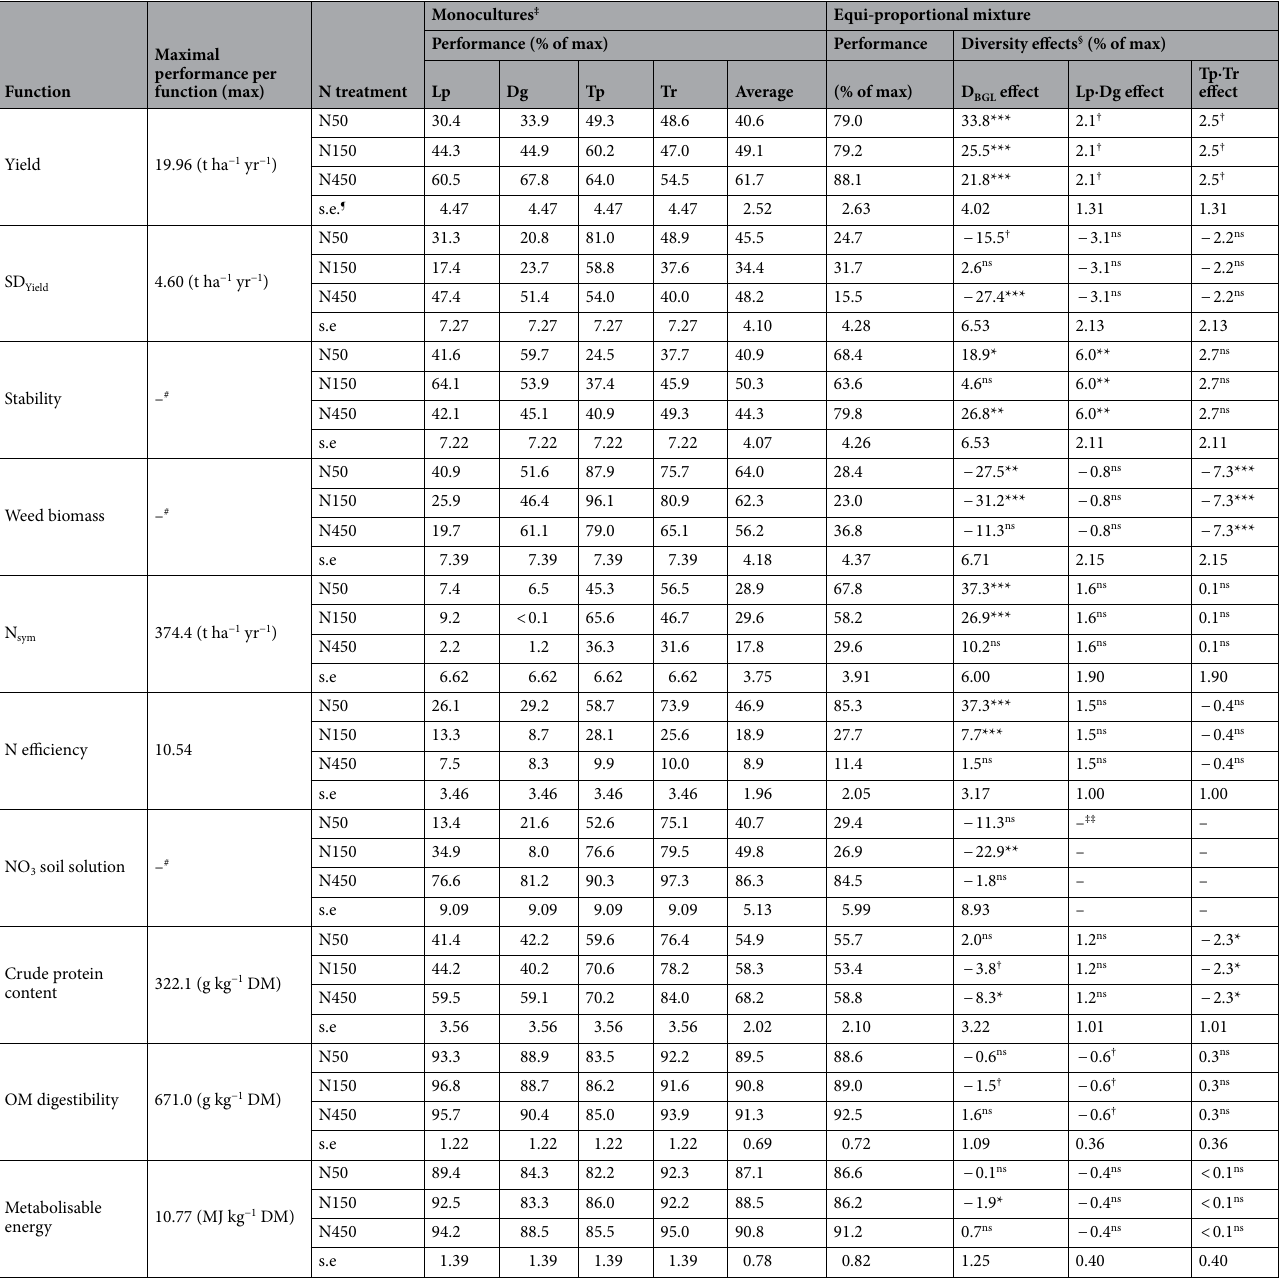
Table 2. Predicted performance of ten functions in monocultures of four forage species and the four-species equi-proportional mixture at three N fertilisation treatments (N50: 50 kg N ha −1 yr −1 , N150: 150 kg N ha −1 yr −1